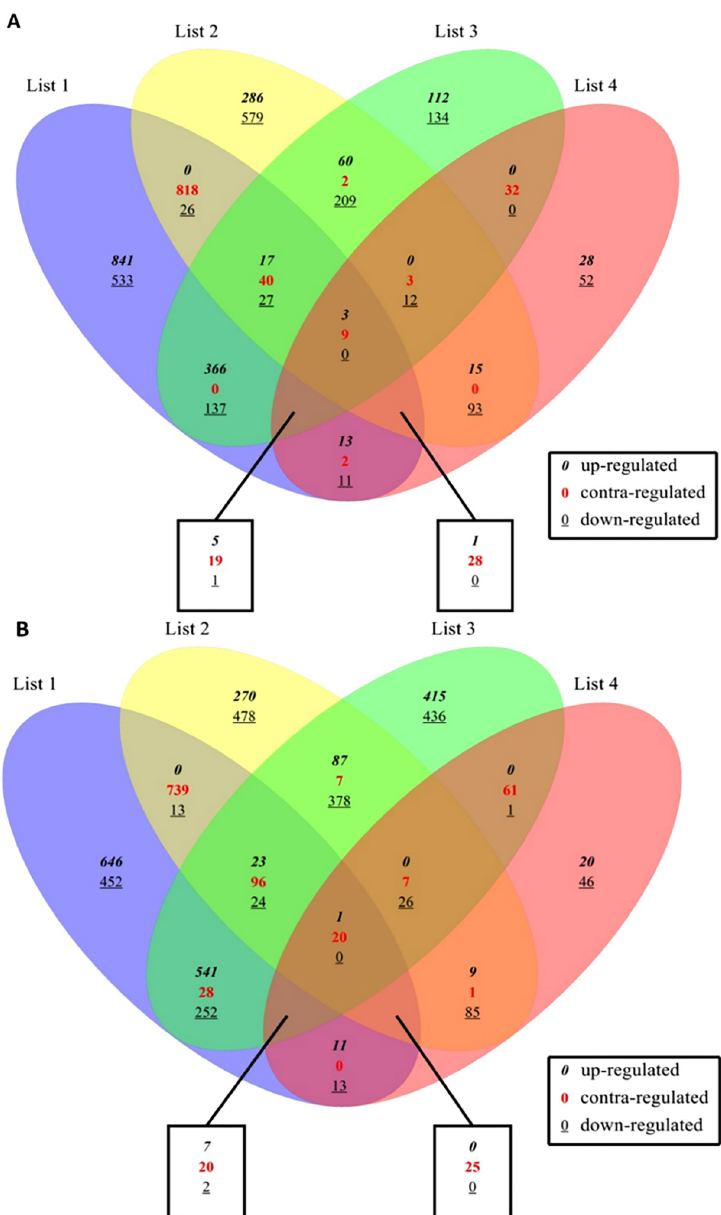
Fig 1. Venn diagram representing the number of transcripts as obtained by mapping with (A). Arachis duranensis genome, and (B). Arachis ipeansis genome of resistant and susceptible peanut genotypes upon Sclerotium rolfsii infection. Where List 1: RI_RC; List 2: RC_SC; List 3: RI_SI; List 4: